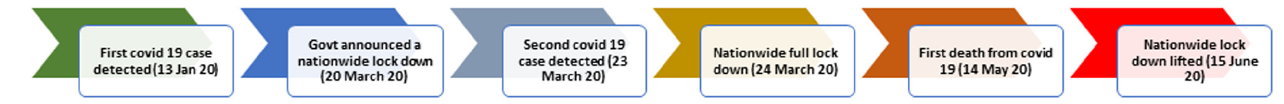
Figure 1. Timeline of COVID-19 related event in Nepal. Sources: Box 1 First covid case: Bastola et al. , 2020 . Box 2 lockdown announcement: Embassy of Nepal, 2020. Box 3 Second covid 19: Dhakal & Karki, 2020. Box 4 Full Lock down: Mahato et al. , 2020 . Box